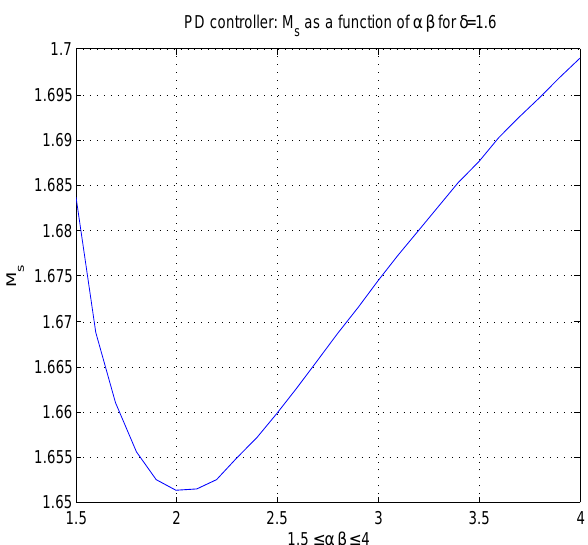
Figure 4: Illustration of sensitivity index M s as a func- tion of the tuning parameter ¯ c = αβ .